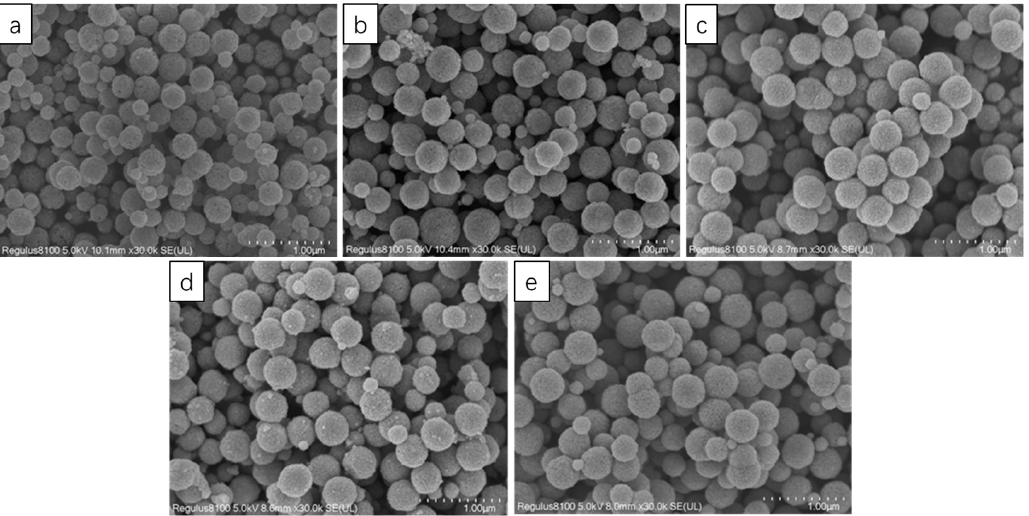
Figure 7. SEM image of Fe 3 O 4 . Solvent amounts: ( a ) 40 mL EG; ( b ) 50 mL EG; ( c ) 60 mL EG; ( d ) 70 mL EG; and ( e ) 80 mL EG.